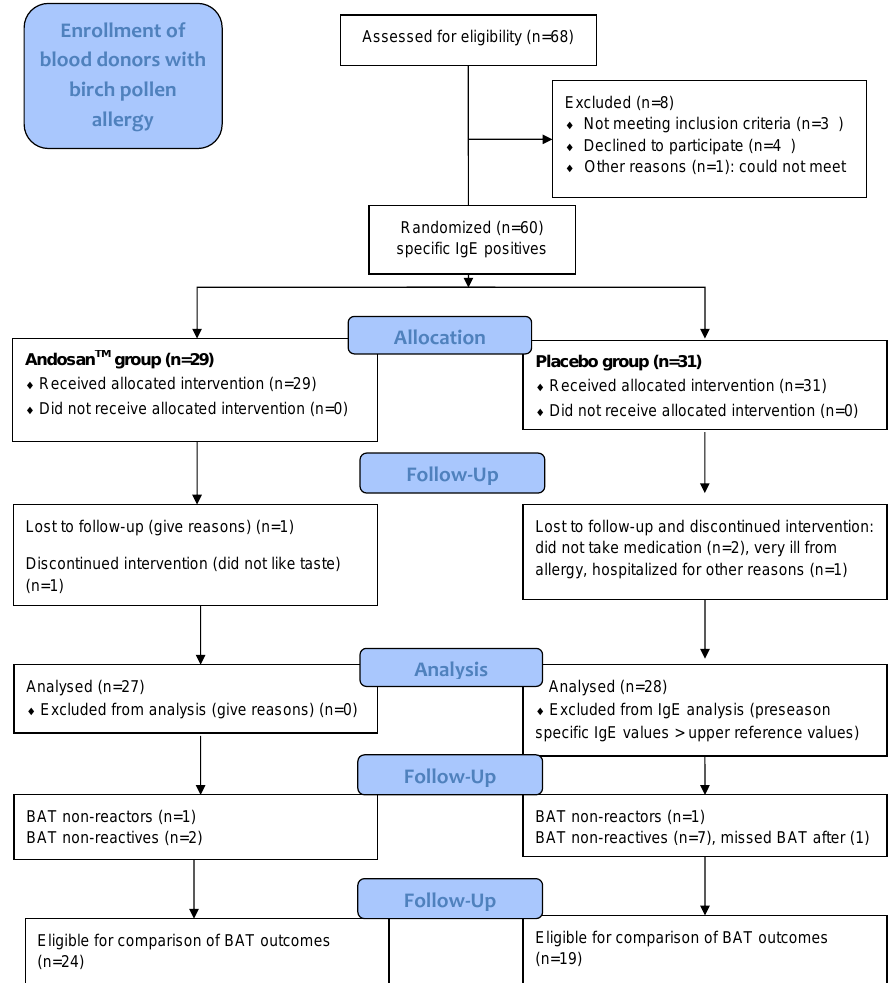
Figure 1. CONSORT (Consolidated Standards of Reporting Trials) 2010 flow diagram. Definitions: specific IgE (IgE anti-Bet v 1), BAT (Basophil Activation